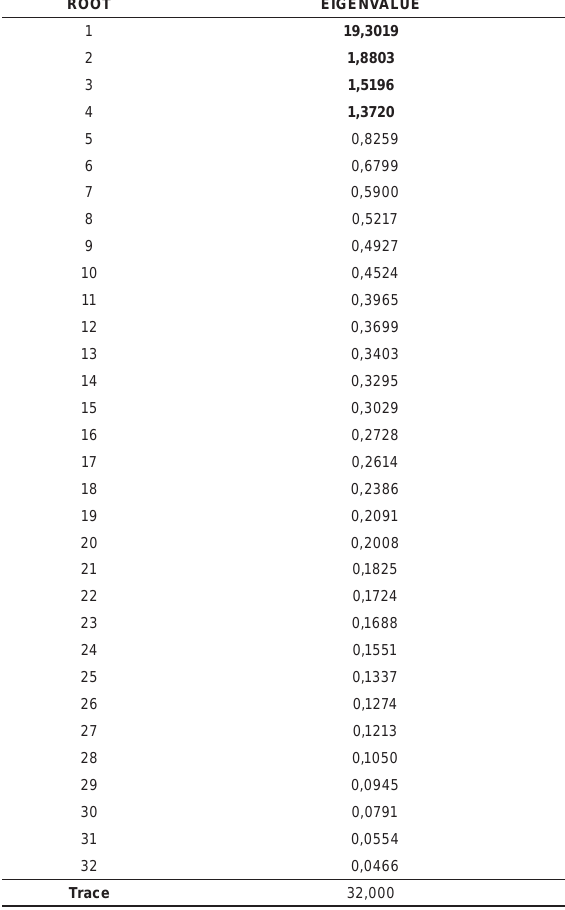
TAbLE 10 Work performance questionnaire: (shortened scale) eigenvalues of unreduced intercorrelation matrix (32 X 32)